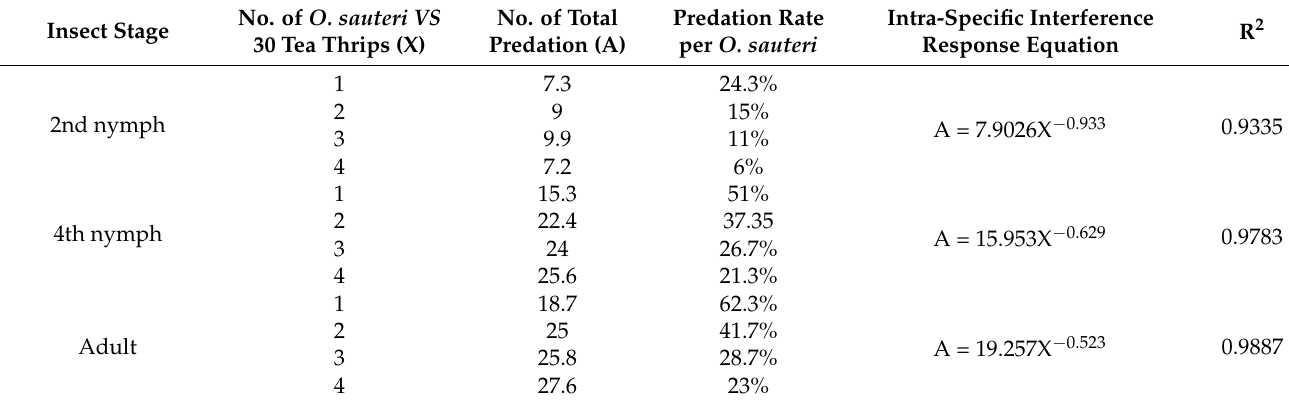
Table 3. Predation rate on tea thrips and intra-specific interference